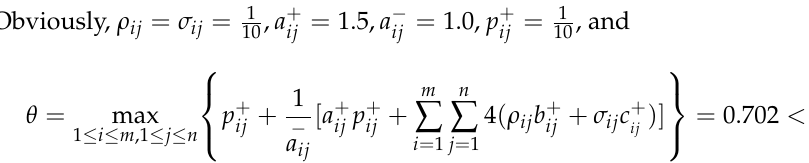
Figure 2. The state trajectory of 22 x , and initial values are 1.0,1.5, 2.0, respectively.